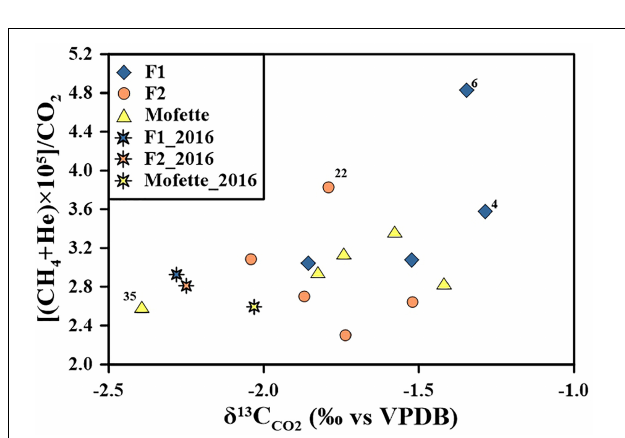
FIGURE 5 | Binary plot of (He+CH 4 ) /CO 2 vs. δ 13 C CO 2 for the gases of Hartoušov. Data of samples collected during 2016 are from Bräuer et al.